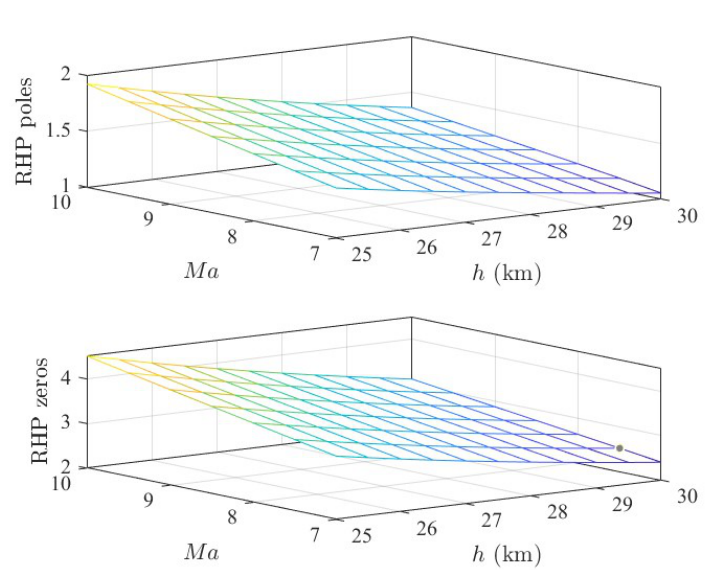
Figure 5. Poles and zeros of the right half plane.